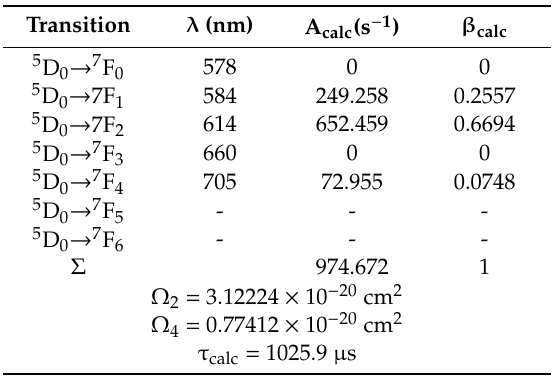
Table 2. The spontaneous emission probabilities, fluorescence branching ratios and asymmetry ratio of BGO: 3% Eu 3 + calculated using the obtained Judd-Ofelt parameters.